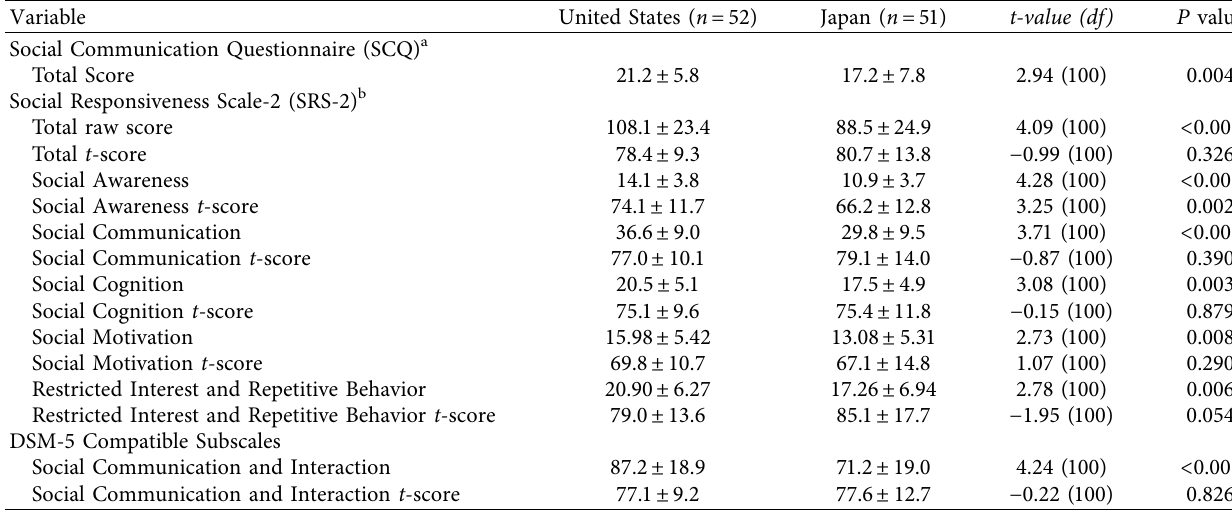
Table 2: Comparison of child ASD characteristics measured by social communication questionnaire (SCQ) and social responsiveness scale- 2 (SRS-2) between the U.S. and